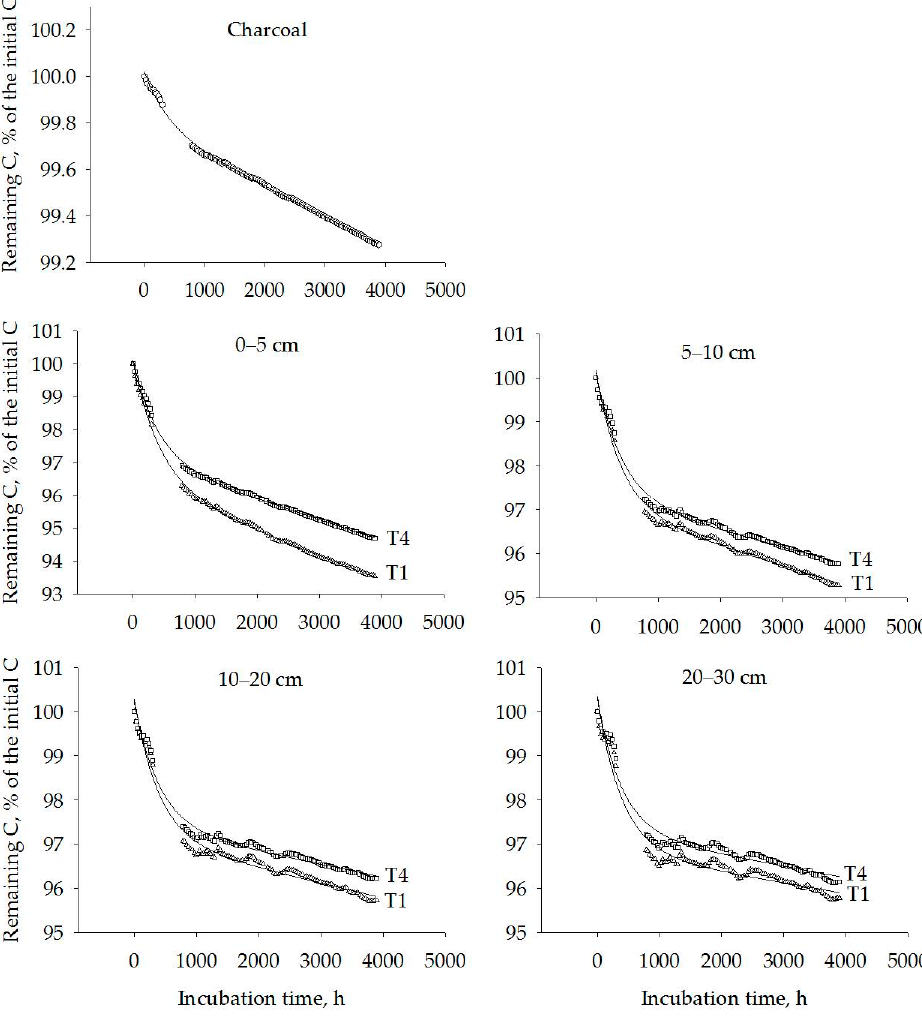
Figure 2. Remaining carbon (C) as a function of incubation time for a Cambisol without charcoal